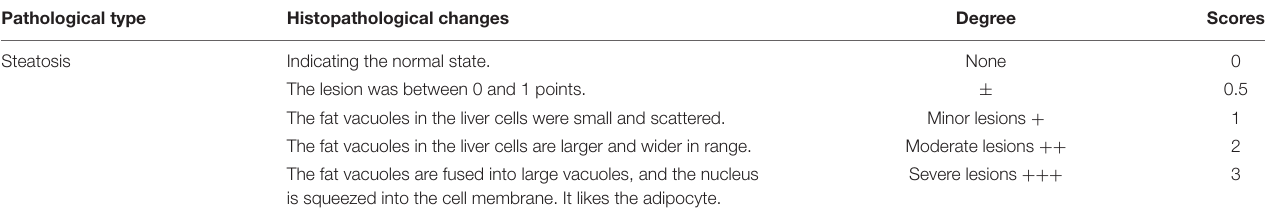
TABLE 5 | The categorization scheme of pathological scores of fatty liver. a